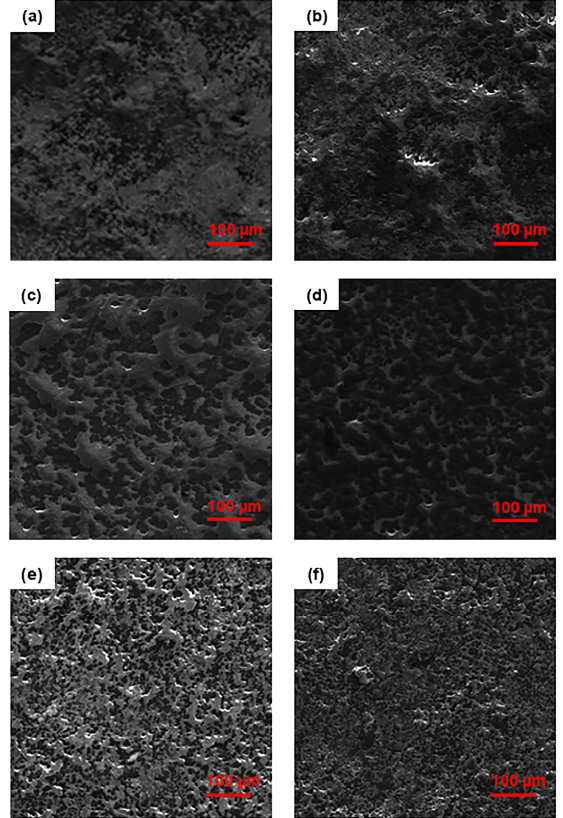
Figure 7. SEM images of non-irradiated ( left ) and irradiated ( right ) samples of ( a , b ) MDPE/GNP 5 wt%, ( c , d ) MDPE/GNP 10 wt%, ( e , f ) MDPE/GNP 15 wt% nanocomposites.